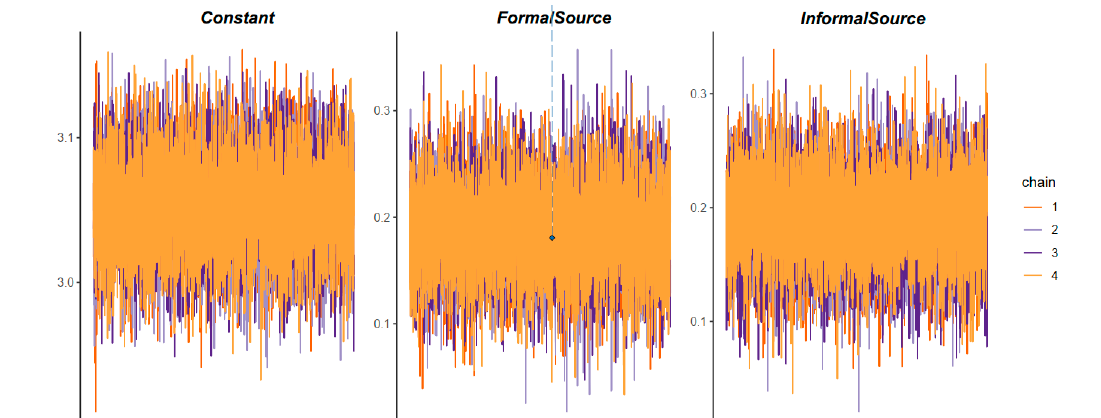
Figure 8. Model 3 ′ s trace plots.